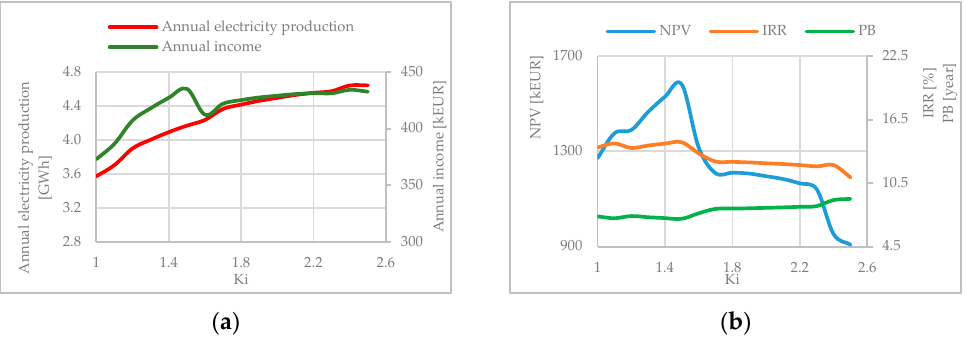
Figure 5. ( a ) Annual electricity production and income—Kaludarska SHPP; ( b ) NPV, IRR, and PB—Kaludarska SHPP.